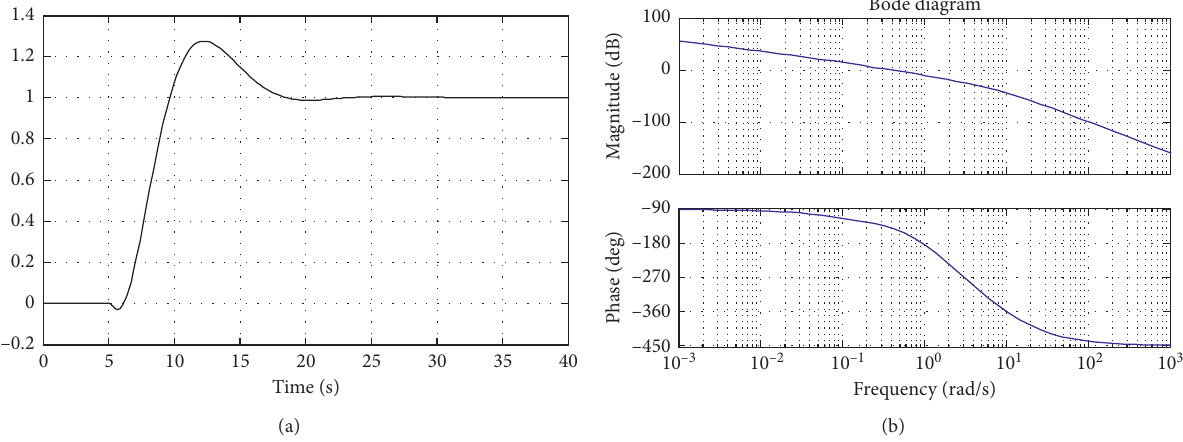
Figure 19: Time domain response and Bode diagram of control closed-loop with k signal. (b) Bode diagram of the open-loop transfer